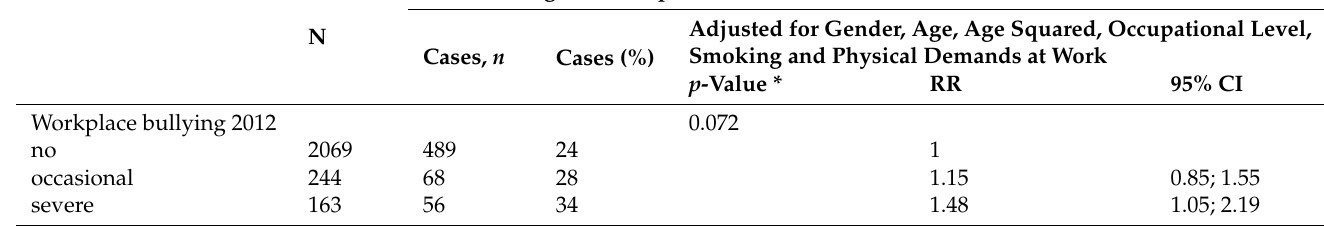
Table 2. Associations between baseline workplace bullying in 2012 and 613 cases of long term sickness absence (LTSA) 2012–2017 among 2476 employees aged 31 to 60 years in Germany in 2012. Multiple binomial regressions. Rate Ratios (RR).